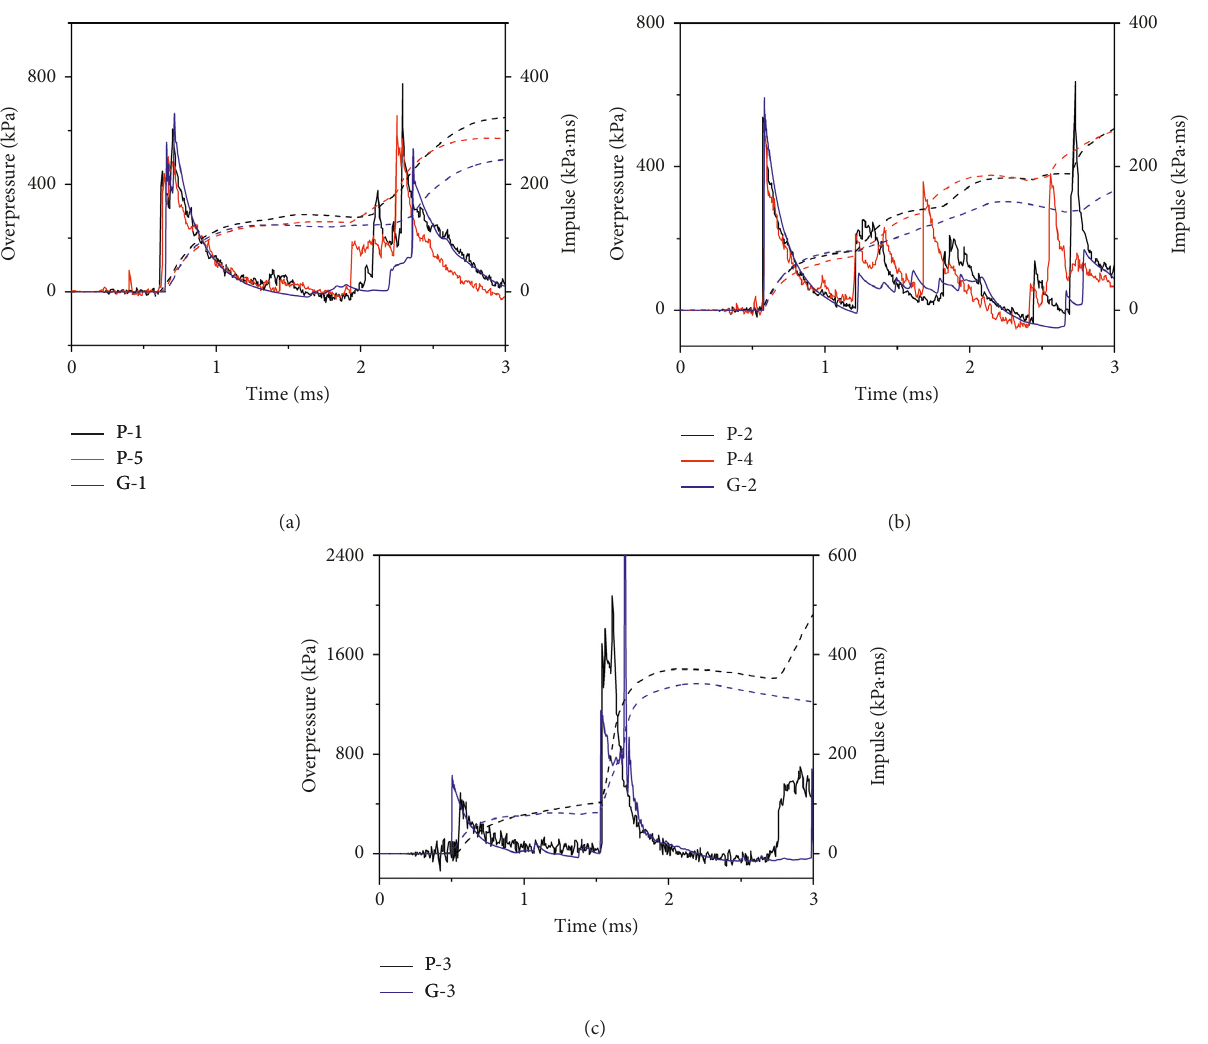
Figure 15: Comparisons between test data and numerical simulation data for scenario T2. Comparison between (a) test and simulation (P1 & P5), (b) test and simulation (P2 & P4), and (c) test and simulation